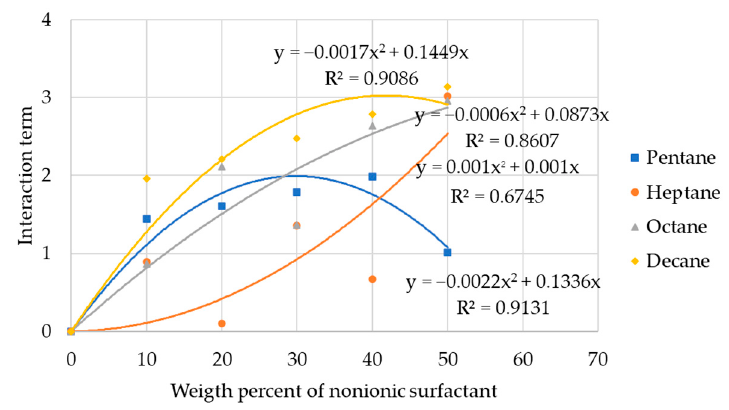
Figure 7. The interaction terms of SDHS-AAE(6EO4PO) systems.